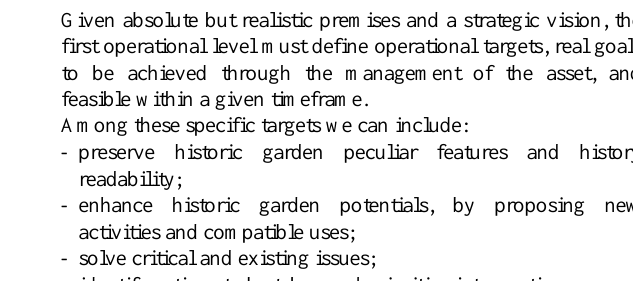
Figure 8. Flow chart of the decisional and operational aspects of the management of an historic